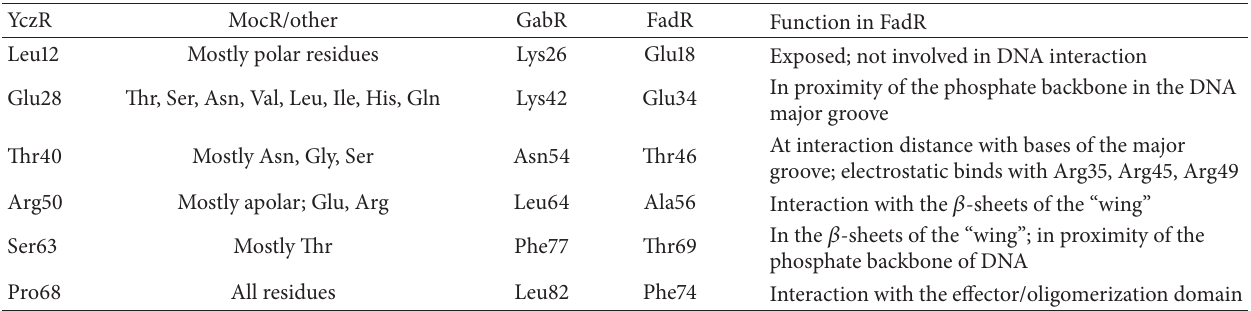
In proximity of the phosphate backbone in the DNA major groove groove; electrostatic binds with Arg35, Arg45, Arg49